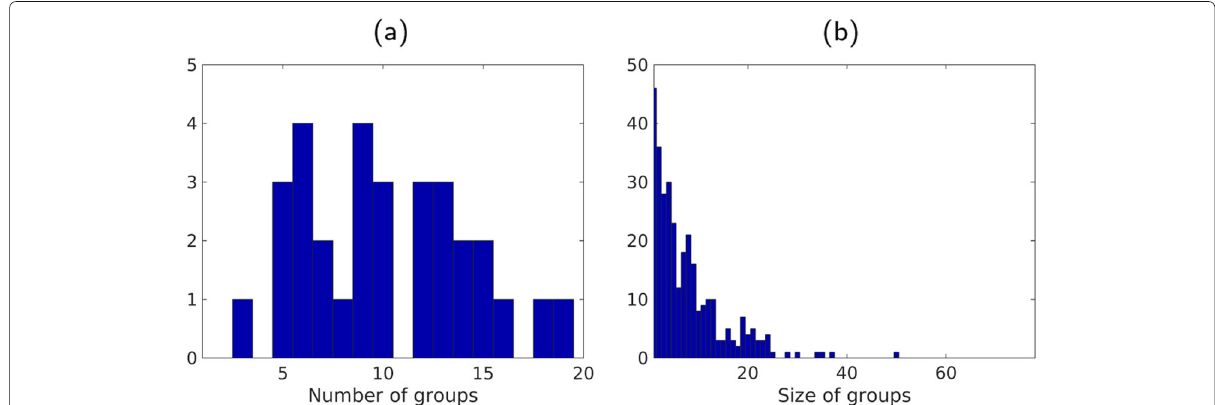
Fig.2 Inter-subject variability. Histogram of the number of clusters a and the size of the clusters b defined by the 31 subjects. See Section 3 for details